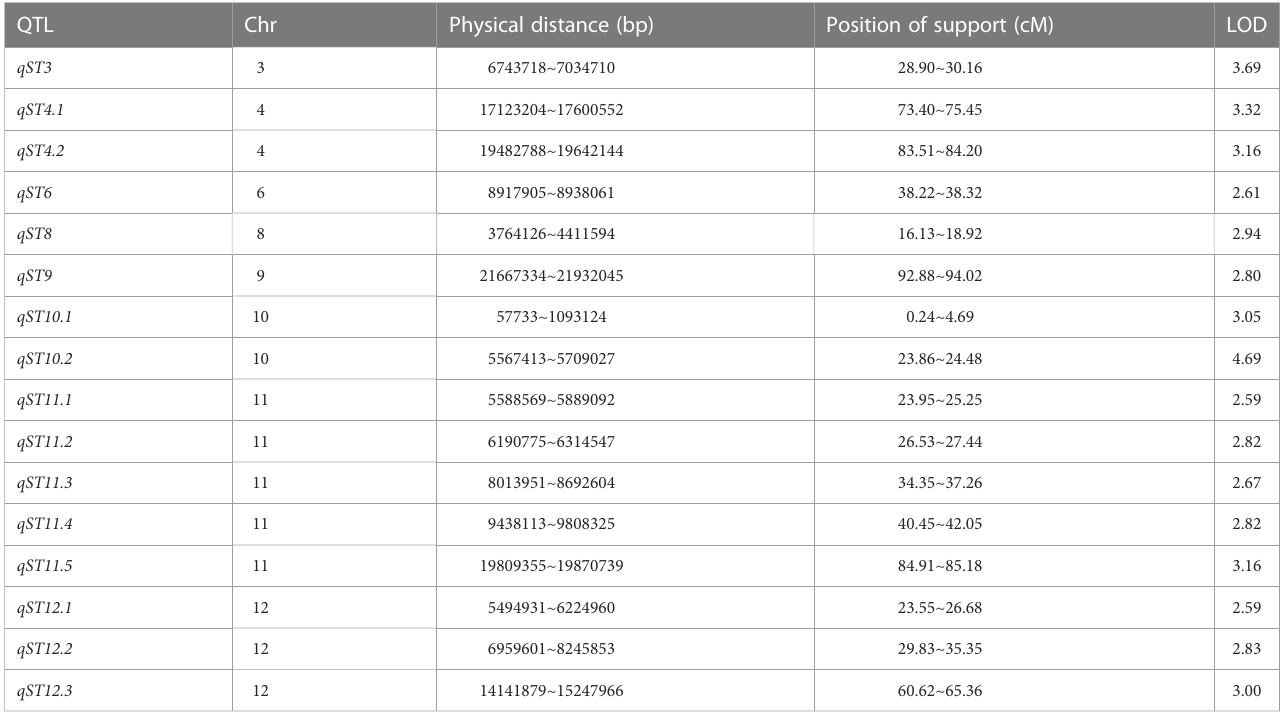
TABLE 1 Mapping of QTL for salt tolerance in